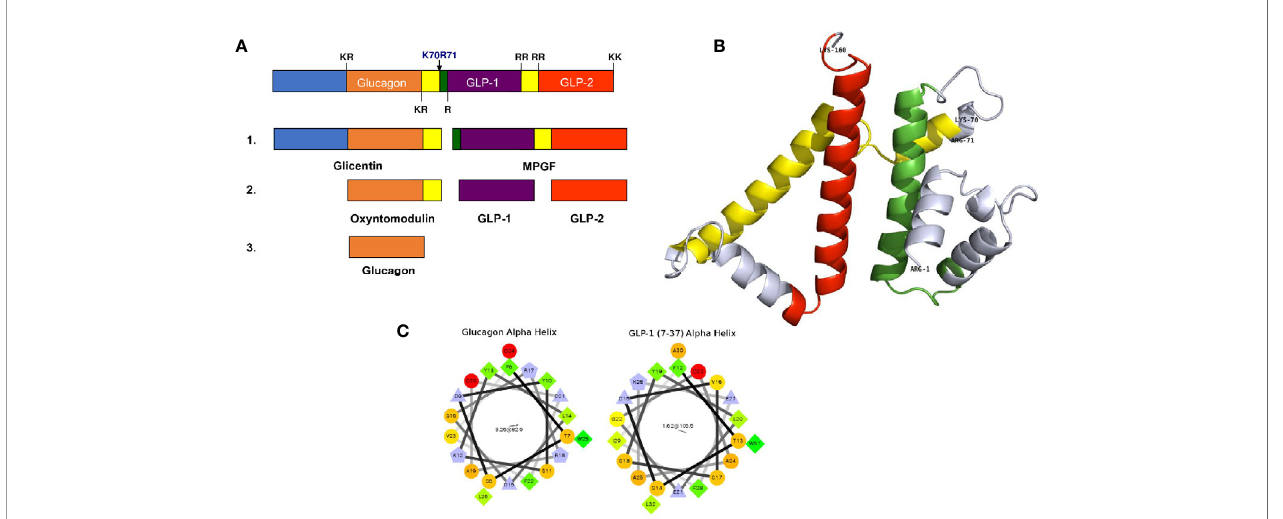
FIGURE 1 | Proglucagon processing and sorting signals. (A) A schematic representation of proglucagon showing the major prohormone processing sites that yield the peptides glicentin, oxyntomodulin, glucagon, GLP-1 and GLP-2. (B) Computational modelling of the structure of proglucagon showing the alpha helical structures of glucagon (green), GLP-1 (yellow) and GLP-2 (red) (from reference 28) © 2013 Society for Endocrinology. (C) Helical wheel projections of the alpha helices contained within glucagon and GLP-1 (7 – 37) that function as sorting signals to direct proglucagon to the regulated secretory